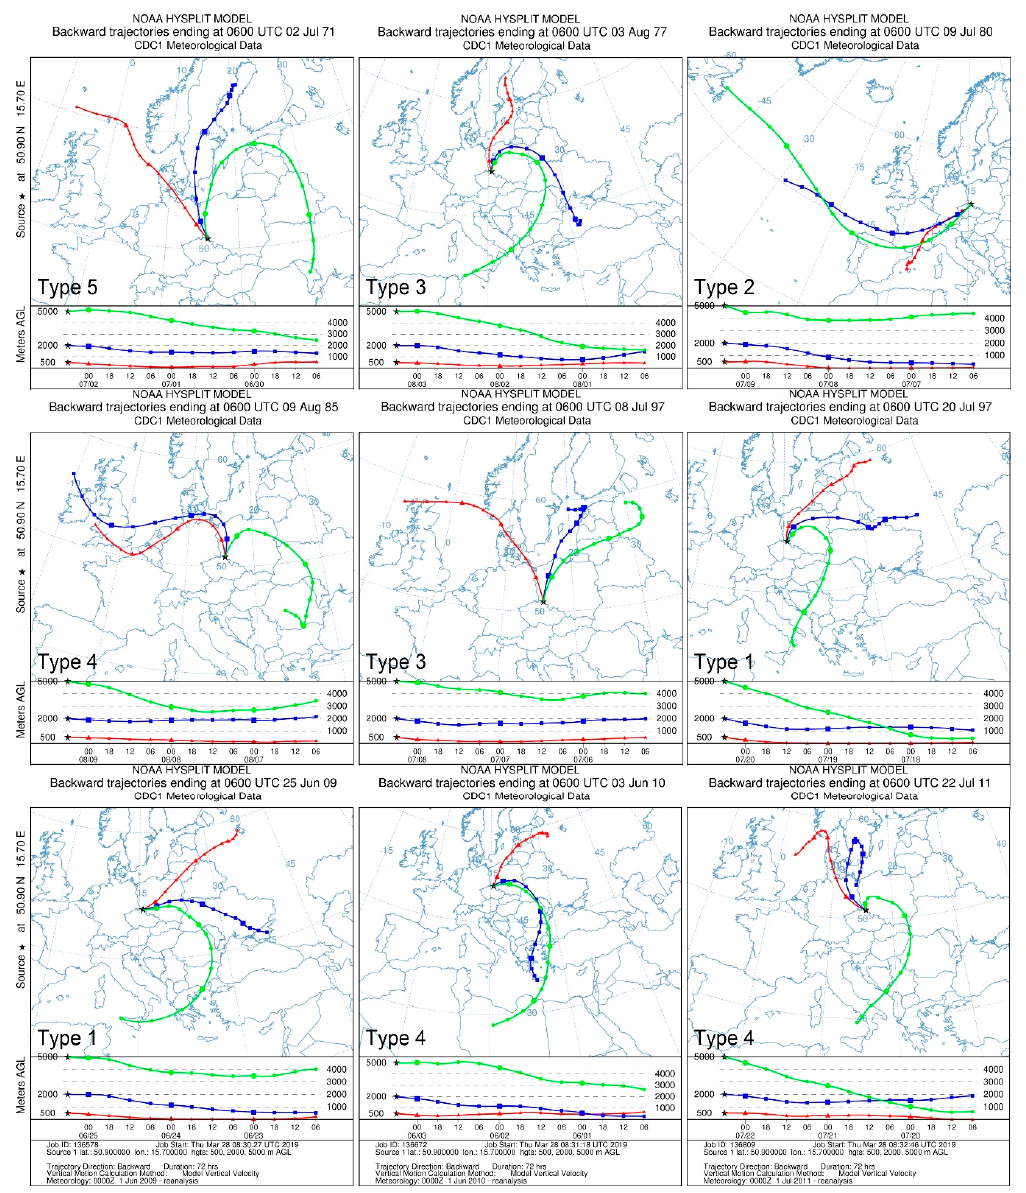
Figure 9. Seventy-two-hour backward trajectories of air parcels determined for the flood culmination day with the circulation type indicated.